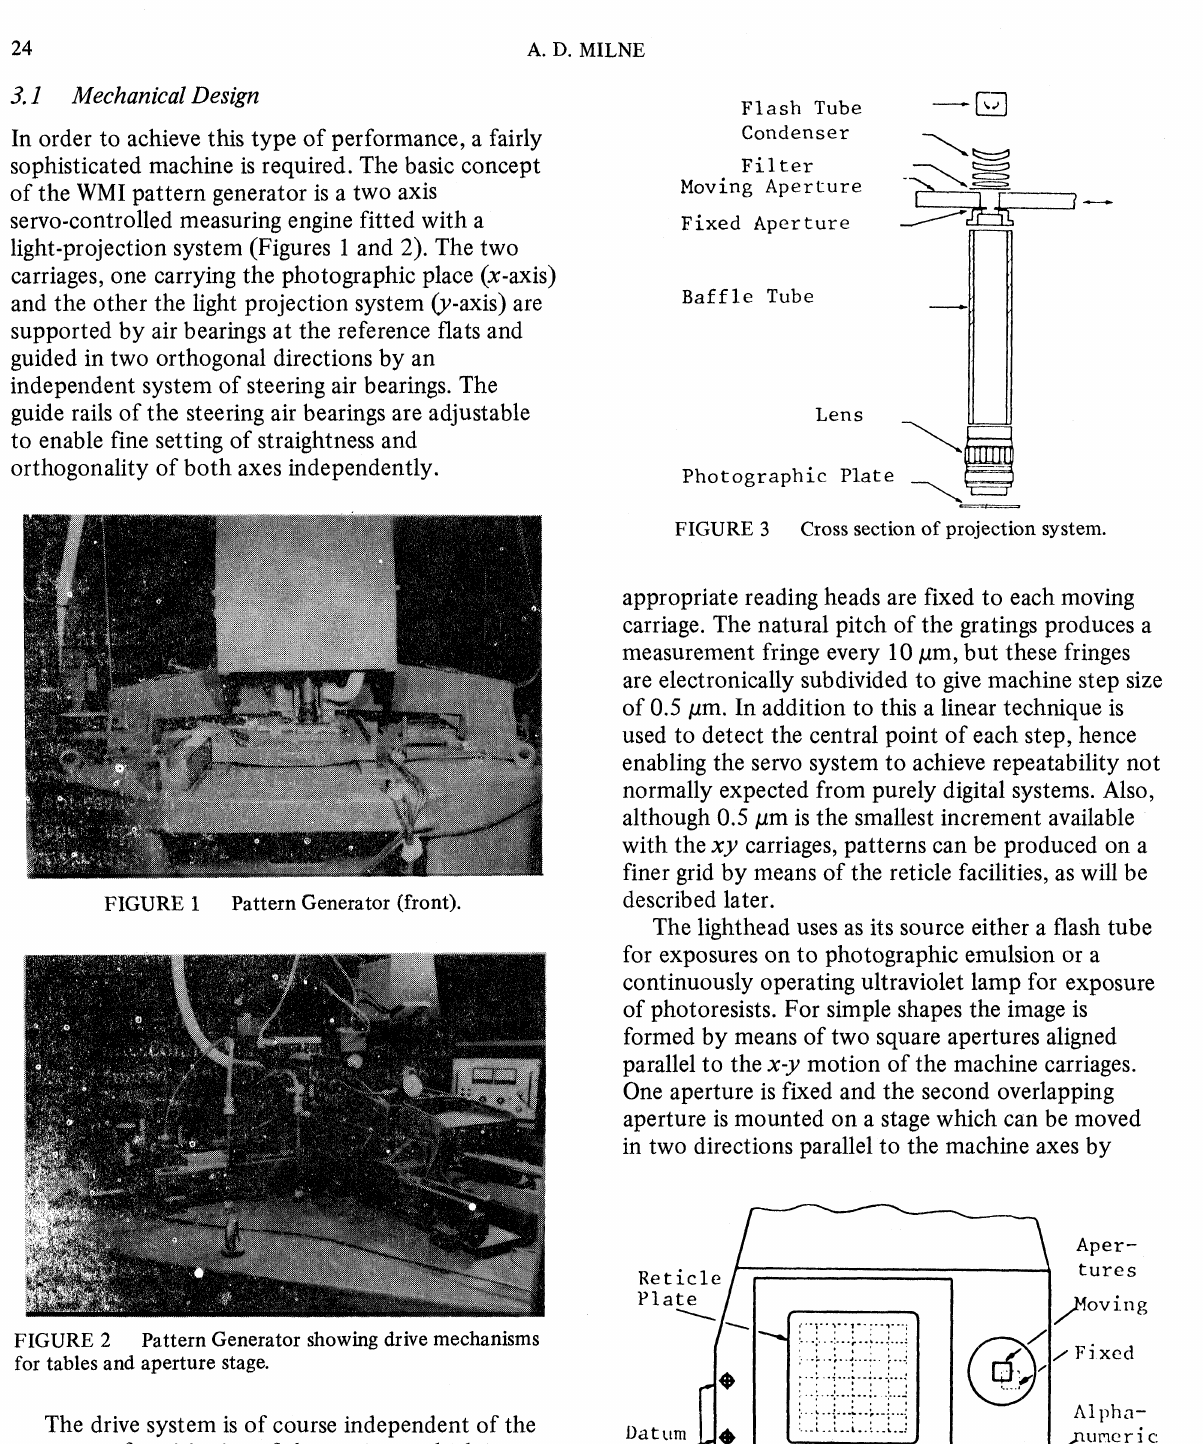
Pattern Generator showing drive mechanisms for tables and aperture